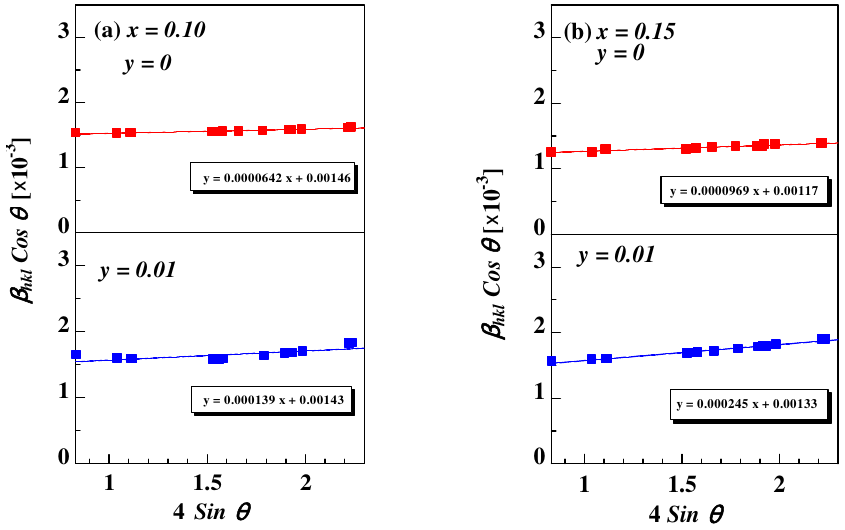
Figure 3. W-H Plot of Eu 2 − x Ce x Cu 1 − y Zn y O 4+ α − δ with x = 0.10 ( a ) and 0.15 ( b ). Table 1. Structural parameters of Eu 2 − x Ce x Cu 1 − y Zn y O 4+ α − δ with x = 0.10; 0.15 and y = 0;